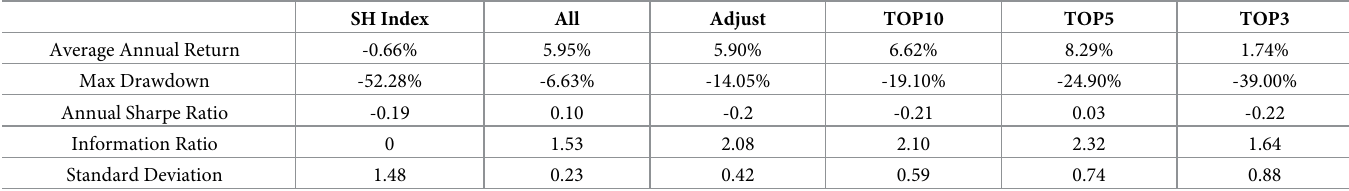
Table 5. Finance performance of three-day patterns predicting one day